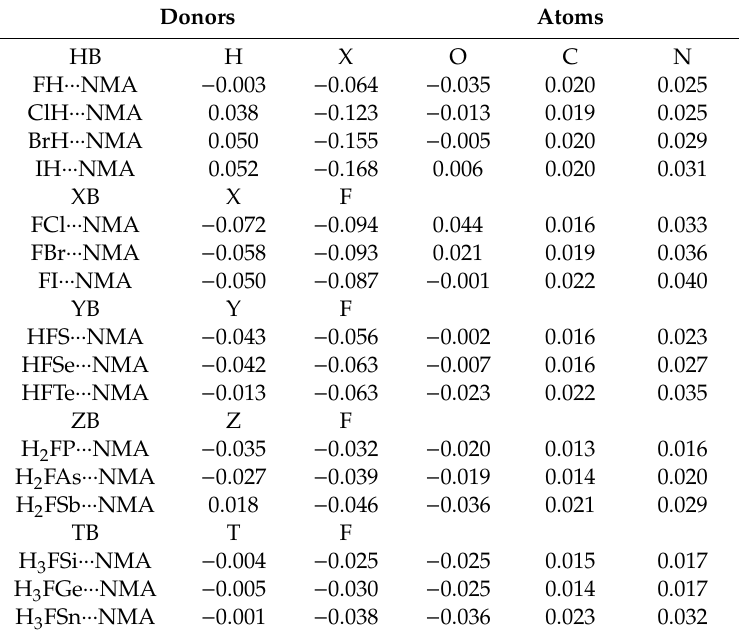
Table 3. Changes of natural atomic charges (e) caused by complexation a